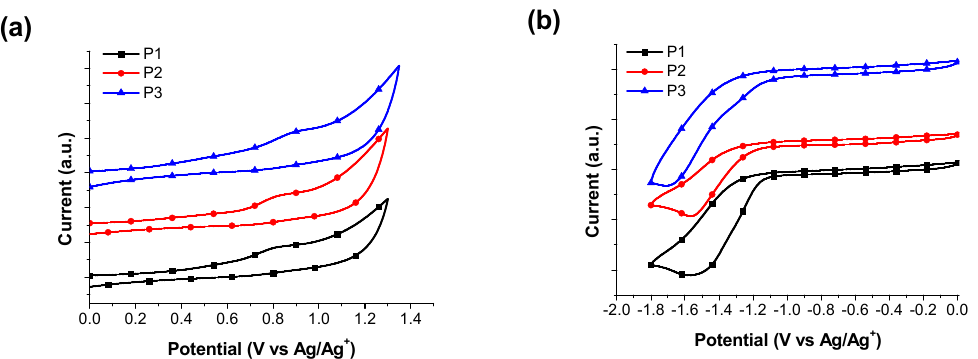
Figure 3. Cyclic voltammograms of copolymer films at ( a ) oxidation, and ( b ) reduction in acetonitrile solution.